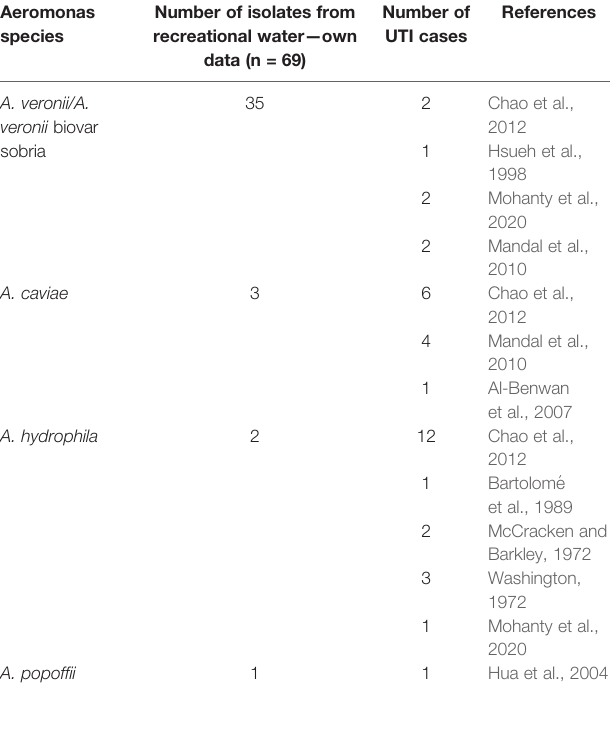
TABLE 2 | Distribution of Aeromonas spp. as the etiological agents of urinary tract infections (UTIs) on the basis of literature data. Aeromonas Number of isolates from species recreational water —